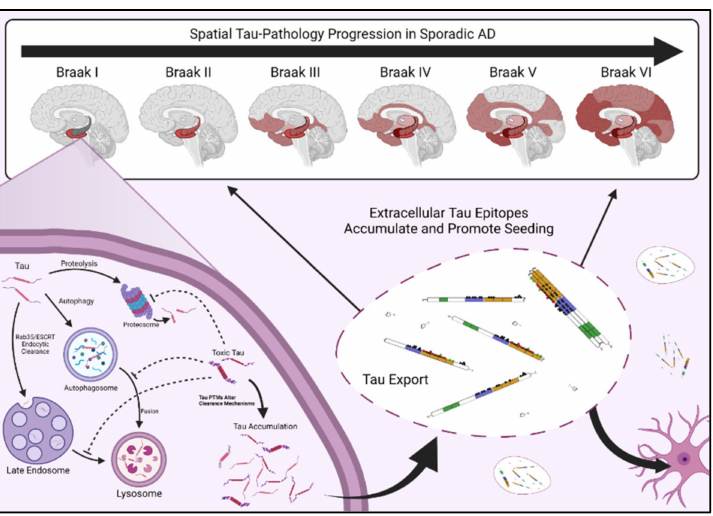
Figure 2. Selective vulnerability and tau accumulation, seeding, and spreading. Tau pathology follows a set track through the brain in most sporadic AD cases [47,48]. Accumulation of NFTs and soluble tau PTM epitopes typically follow the same path as the disease progresses. In vulnerable neurons, tau PTMs can interfere with tau clearance and lead to tau accumulation. Toxic tau PTMs, like tau truncation, are likely to drive tau export from diseased neurons. Though the mechanisms of tau transfer between neural cells are still being debated, increased abundance in extracellular tau is a hallmark of AD, and toxic tau PTM epitopes may drive the spread of pathology from one brain region to the